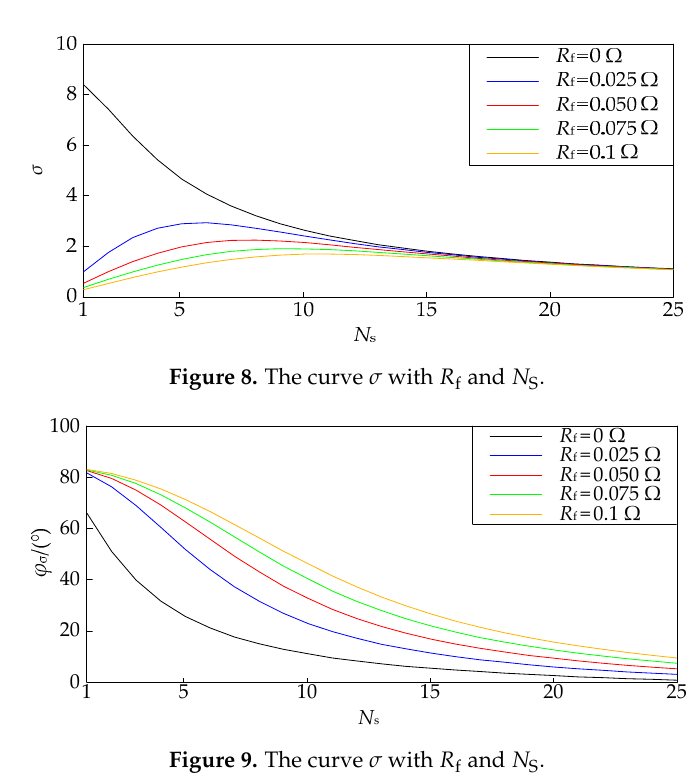
Figure 9. The curve σ with